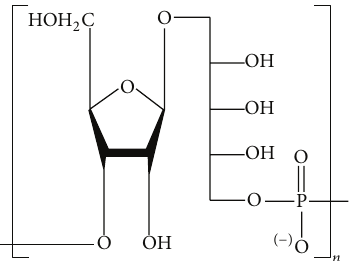
Figure 1: H. influenzae type b capsular polysaccharides repeating